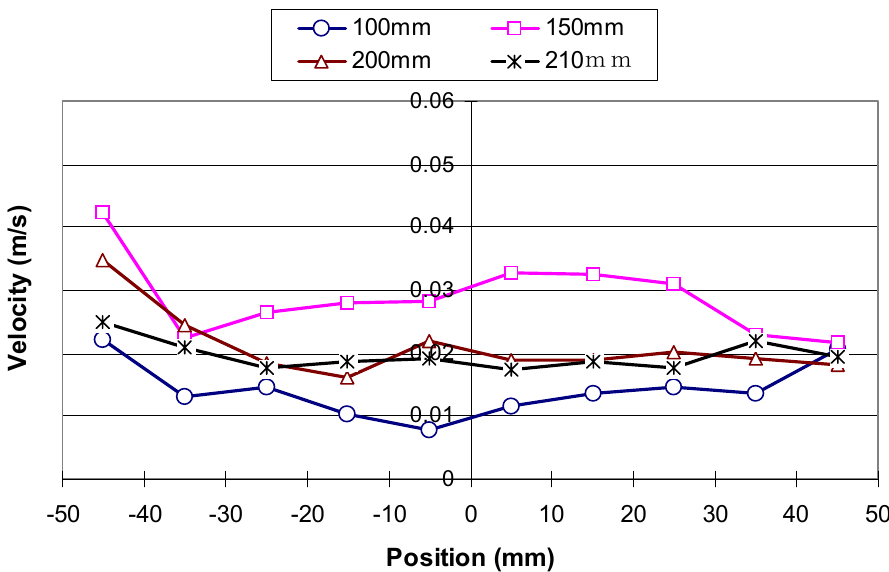
Fig. 14 : Y-direction velocity for 0-degree and with fire-tube conditions